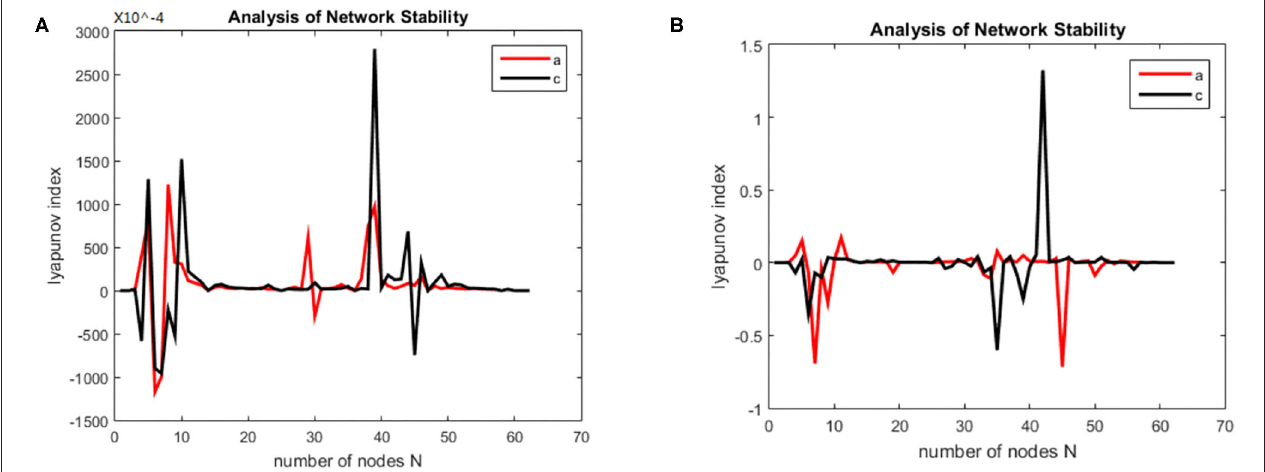
FIGURE 4 | Changes in the Lyapunov exponents in different frequency bands. (A) Change of Lyapunov exponent in alpha band. (B) Change of Lyapunov exponent in theta